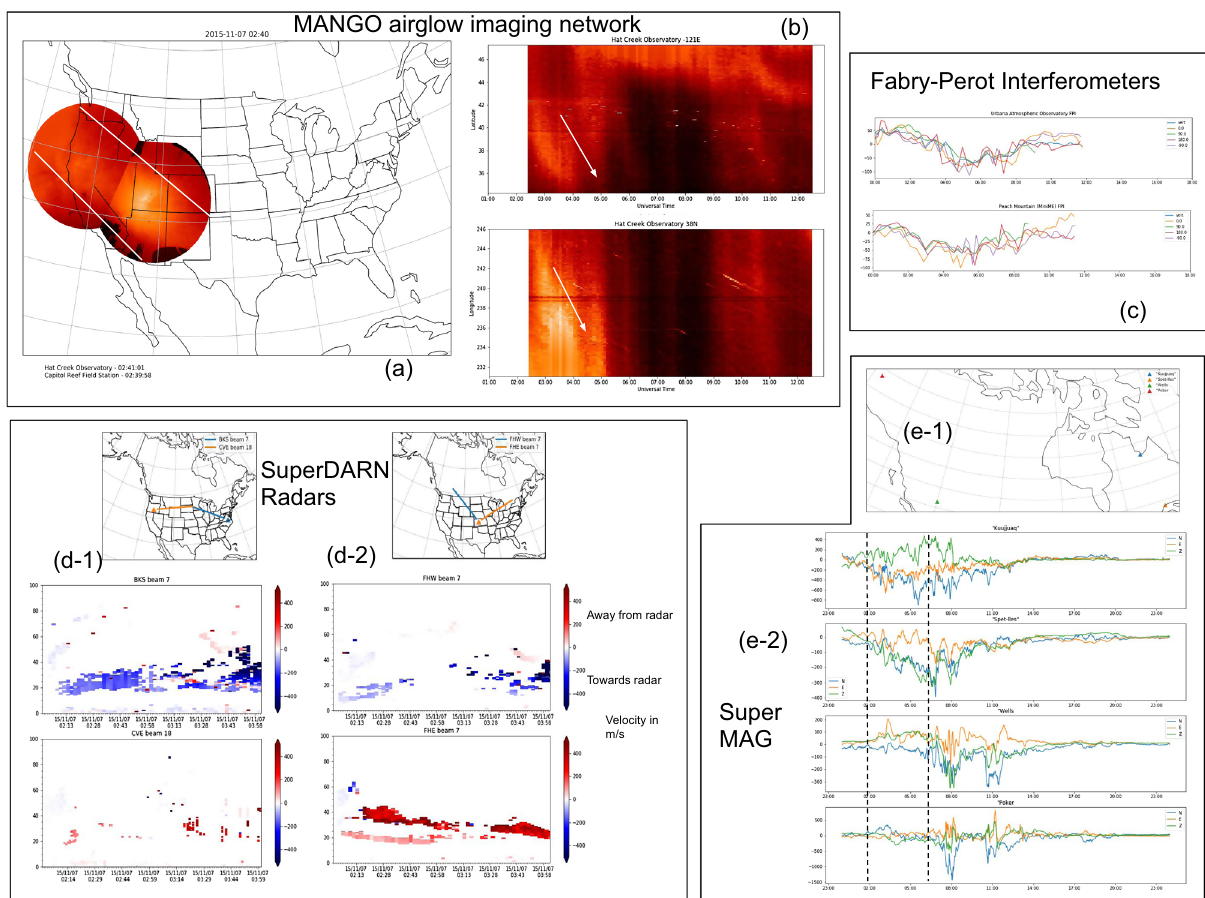
Fig. 4. A fi gure palette containing images made within Resen from diverse data sources. (a) MANGO mosaic image created using functionality of the mangopy library installed within resen-core . The image shows large enhanced airglow band tilted southwestward in two western imagers. (b) Keograms (north-south and east-west cuts at speci fi c longitude and latitude respectively) created for the Hat Creek (western most) imager showing a signature of a southward and westward propagating LSTID from 0230 UT to 0400 UT, also indicated by arrows. (c) Two FPIs from Urbana and Peach Mountain in mid-eastern United States showing southwestward winds between 0200 UT and 0600 UT. 0 (cid:3) is north and 90 (cid:3) is east. The positive values always refer to northward or eastward. FPI data were downloaded using the madrigalweb library installed in resen-core . (d) SuperDARN radar velocities from four northern hemisphere radars. The beam directions are shown in the maps at the top of d-1 and d-2 panels. The Blackstone SuperDARN radar (BKS) beam 7 shows negative velocities, which are westward, and the Fort Hayes East (FHE) beam 7 shows positive velocities that are southwestward. SuperDARN data acquisition was done outside of Resen, but analysis used the Python library DaViTPy developed by the SuperDARN consortium. (e) Four magnetometer sites from the SuperMAG network show the magnetometer fl uctuations indicating high geomagnetic activity, which seems to progress from north to south and east to west, as indicated by two dashed lines. SuperMAG data were downloaded separately, and uploaded to the Resen